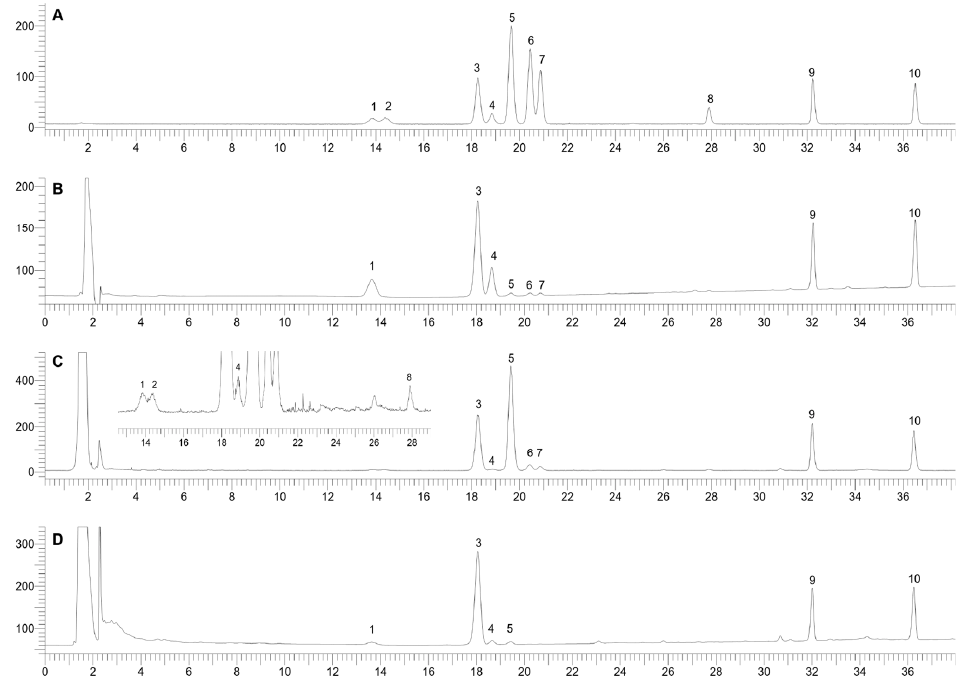
Figure 2. HPLC chromatograms of a standard mixture detected by ELSD ( A ) and UV ( B ); PV extract detected by ELSD ( C ) and UV ( D ). 1, N-R1; 2, M-R1; 3, G-Rg1; 4, G-Re; 5, M-R2; 6, p-RT4; 7, V-R11; 8, V-R2; 9, G-Rb1; 10, G-Rd.